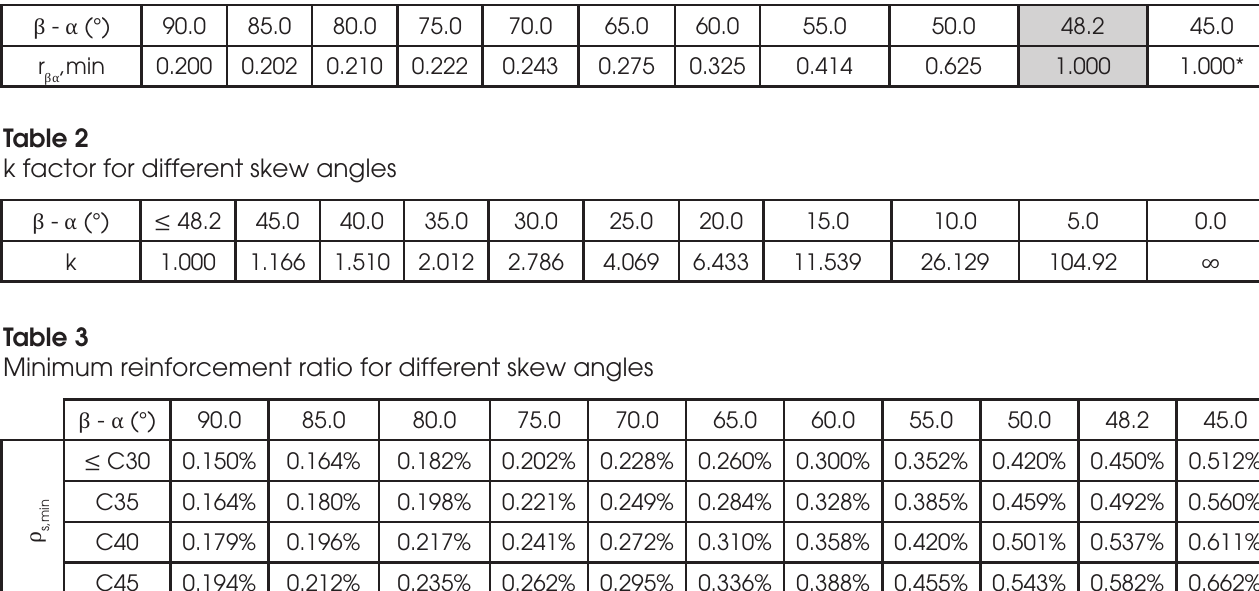
Minimum secondary reinforcement for different skew angles